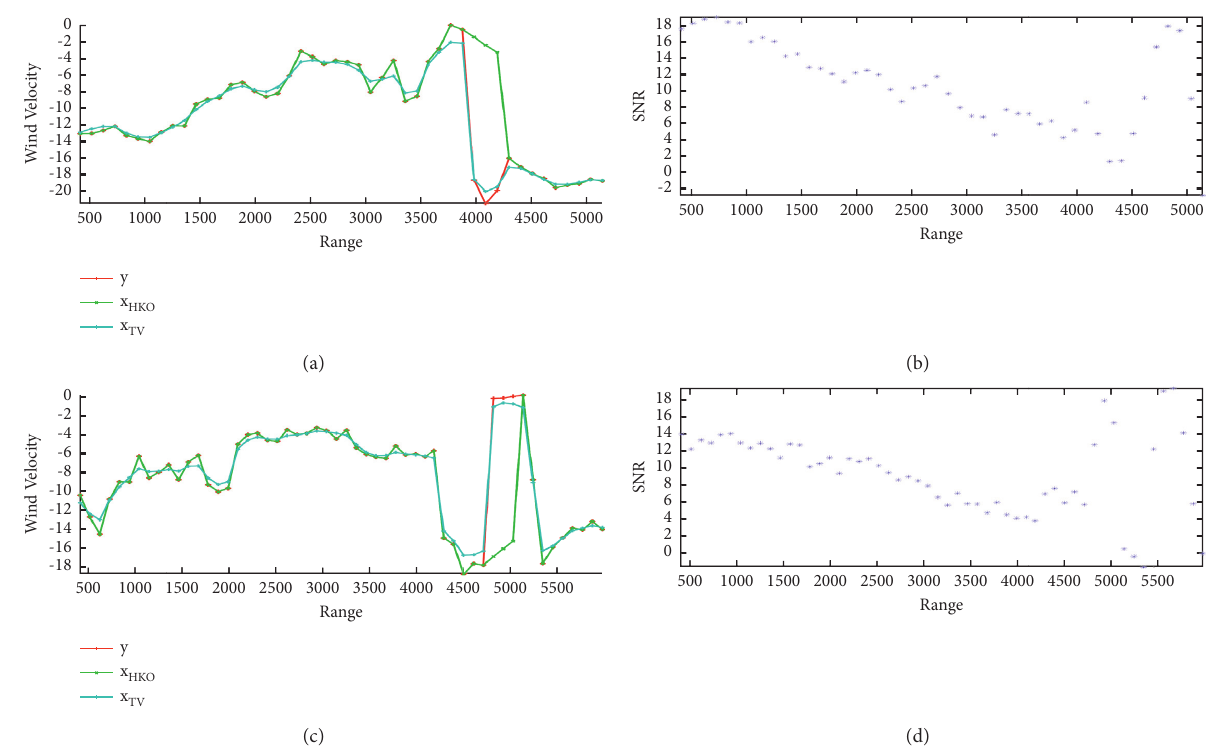
Figure 6: The denoising results by the proposed method x and the HKO method x . (a) The LiDAR data were collected on 4 March TV HKO 2015 from 21:26 :16 to 21: 46:39 with a fixed azimuth angle 124 ° and the denoising results. (b) The SNR values of the LiDAR data in the 1st row. (c) The LiDAR data were collected on 5 March 2015 from 04:16: 02 to 04:16: 25 with a fixed azimuth angle 139 ° and the denoising results. (d) The SNR values of the LiDAR data in the 3rd